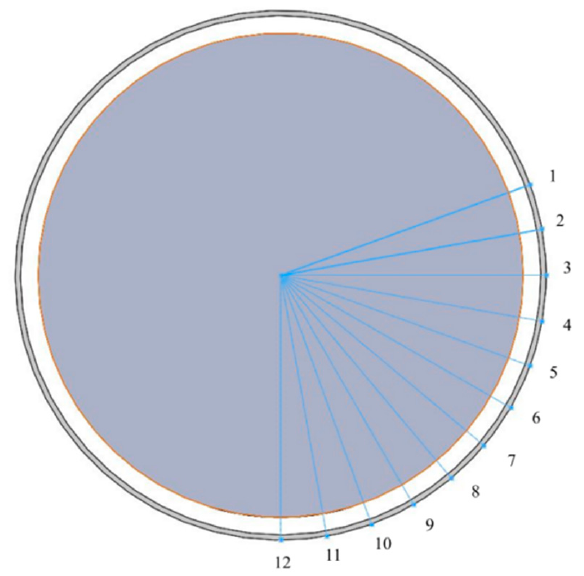
Figure 7. Magnetic field test path along circumference direction.